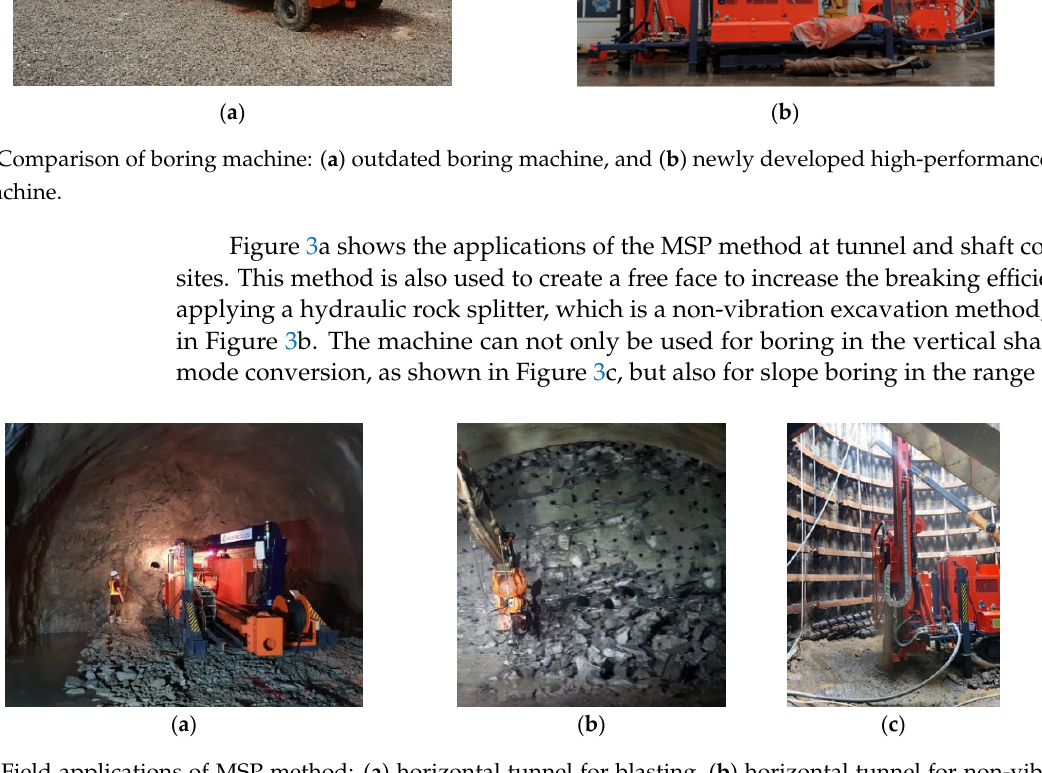
Figure 3. Field applications of MSP method: ( a ) horizontal tunnel for blasting, ( b ) horizontal tunnel for non-vibration excavation, and ( c ) vertical shaft for blasting.